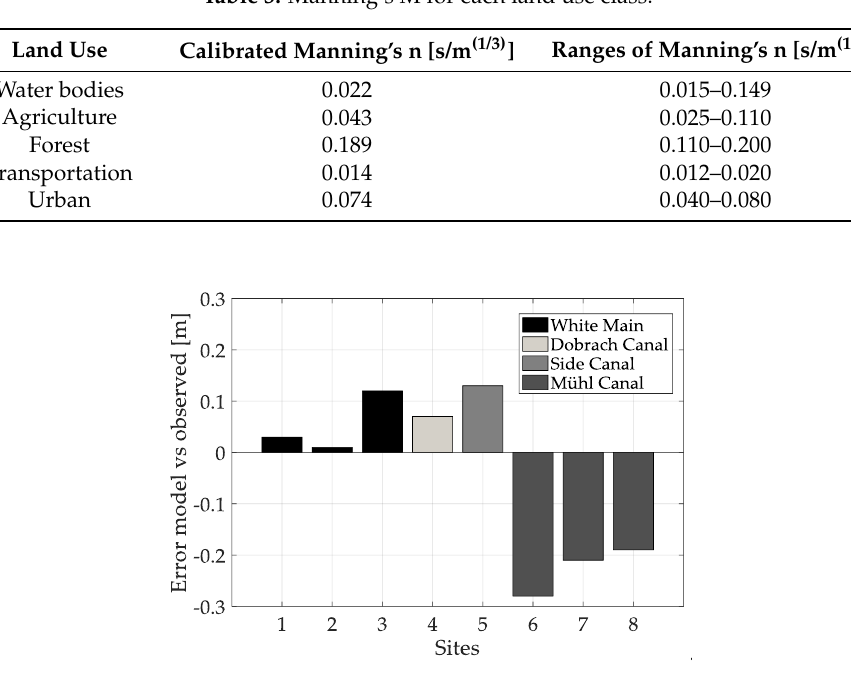
Figure 5. Error in m between the water levels resulting from the calibrated model and the measured water levels on 14 January 2011 at eight sites.